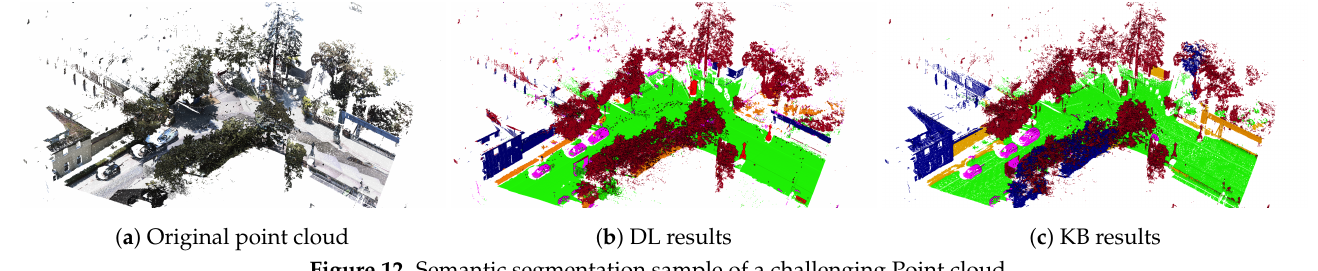
Figure 12. Semantic segmentation sample of a challenging Point cloud.